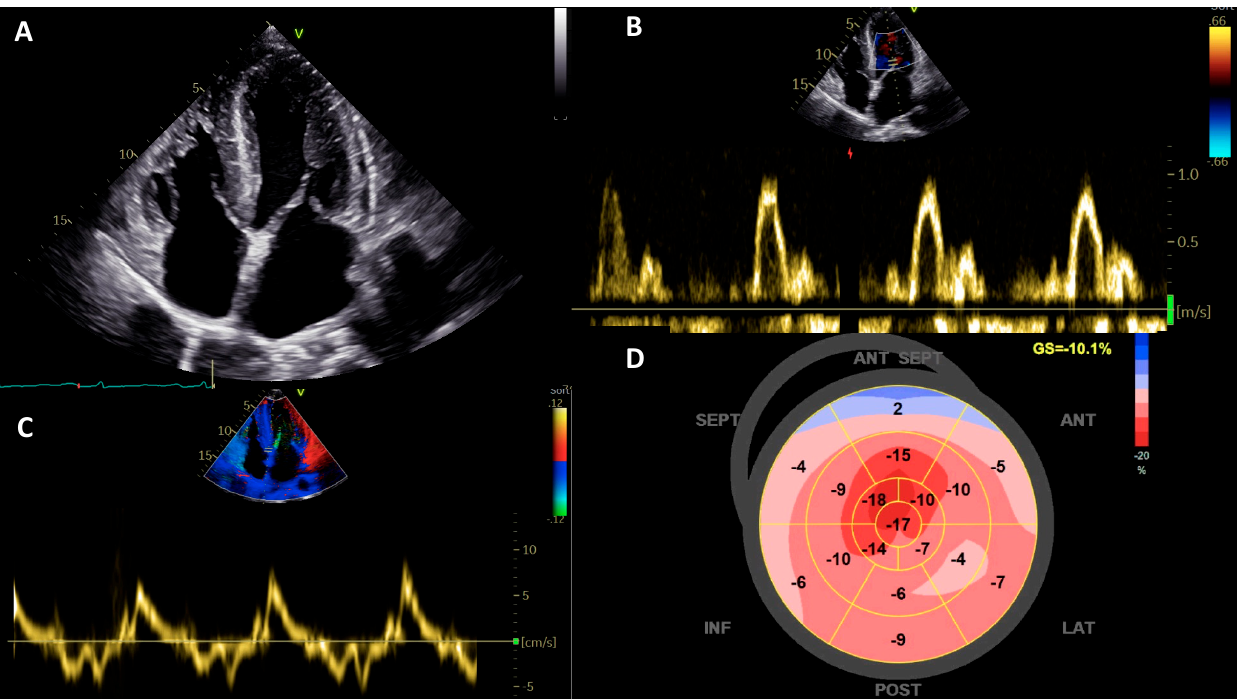
Figure 2. Echocardiographic clues of a patient with AL cardiac amyloidosis ( A ): Apical four-chamber view demonstrates increased biventricular wall thickness with a sparkling texture of the myocardium, thickening of the interatrial septum, and biatrial enlargement. ( B ): Restrictive diastolic pattern. ( C ): Tissue Doppler imaging taken at the septal mitral annulus showing low e’ velocities. ( D ): Global longitudinal strain with the apical sparing pattern.